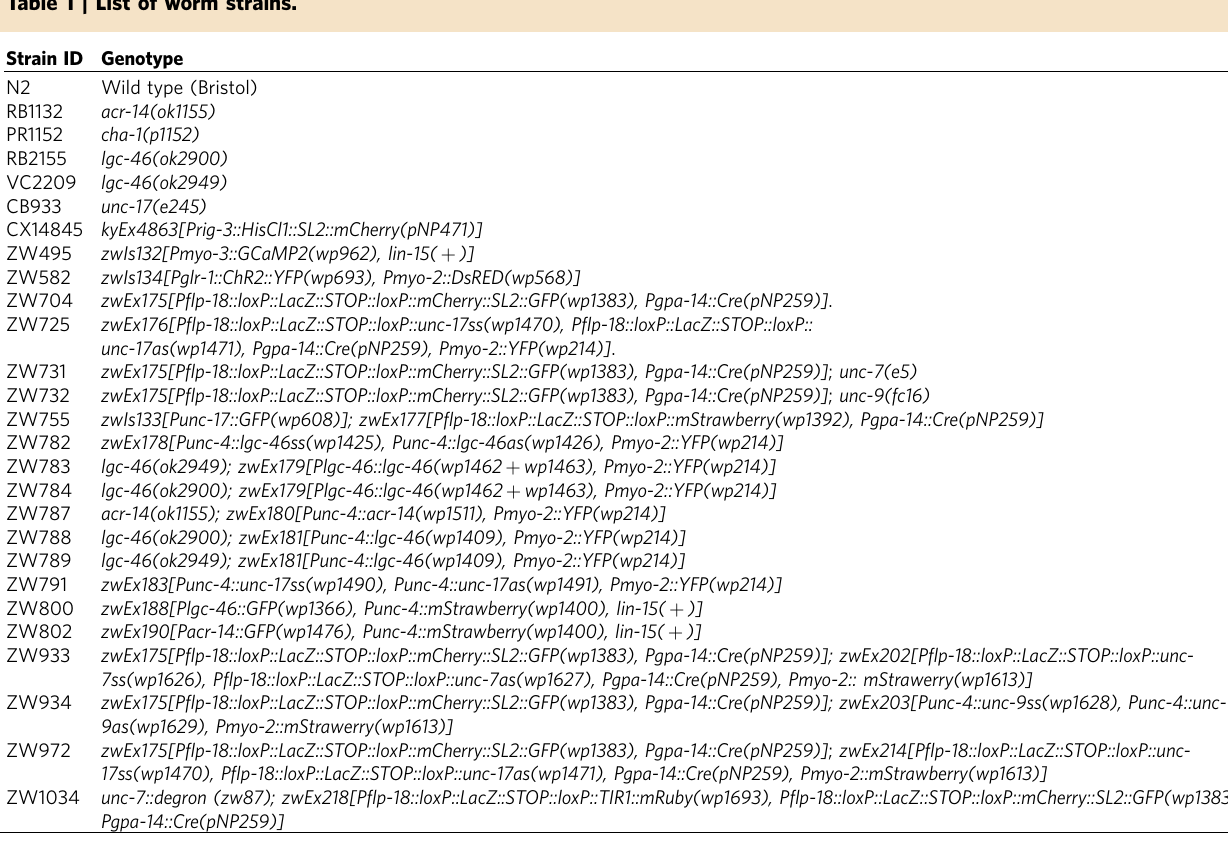
Table 1 | List of worm strains. Strain ID Genotype N2 Wild type (Bristol)